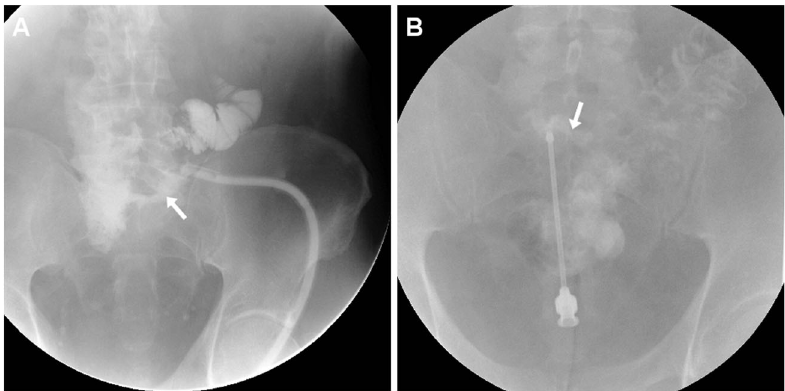
Fig. 1 Two fistulography examples. A Fistulography performed via a catheter piercing through the external fistulous opening (EFO) in a 74- year-old man with history of repeated surgeries to manage bowel obstruc- tion, adhesions and anastomotic dehiscence: optimal visualisation of course and length of the enterocutaneous fistula (ECF, arrow), in